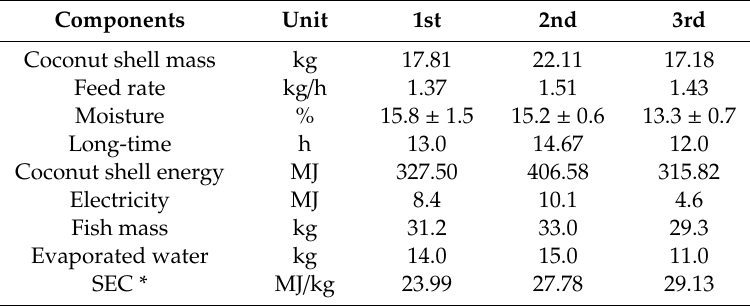
Table 2. Data of three